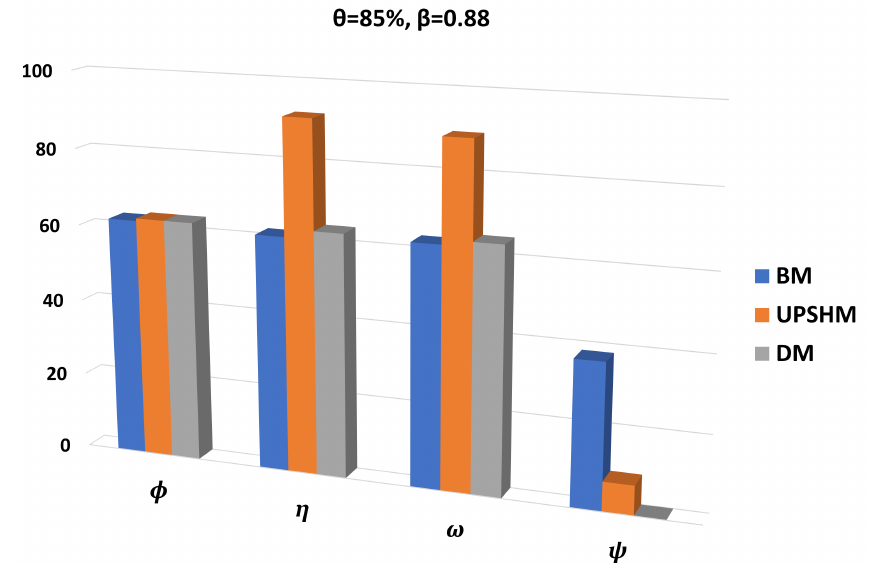
Figure 5. Comparison of results for all performance metrics, for θ = 85% and β =